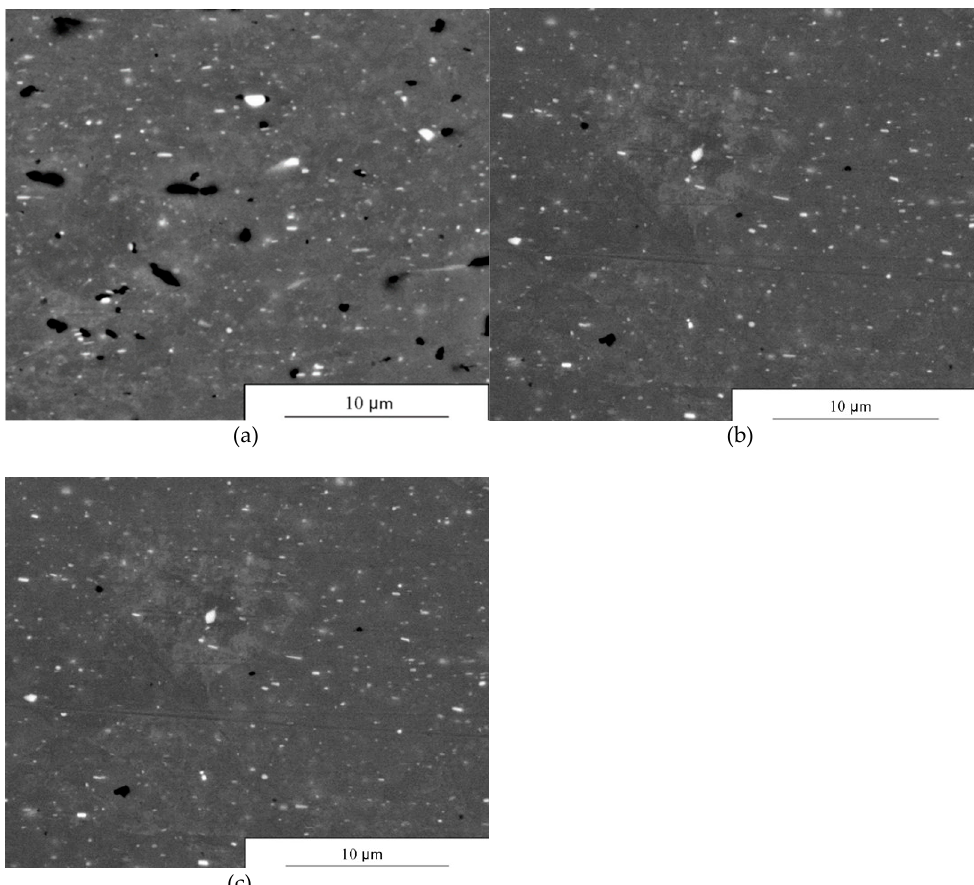
Figure 9. Dispersoids after annealing ( a ) 250 °C, ( b ) 350 °C and ( c ) 500 °C.